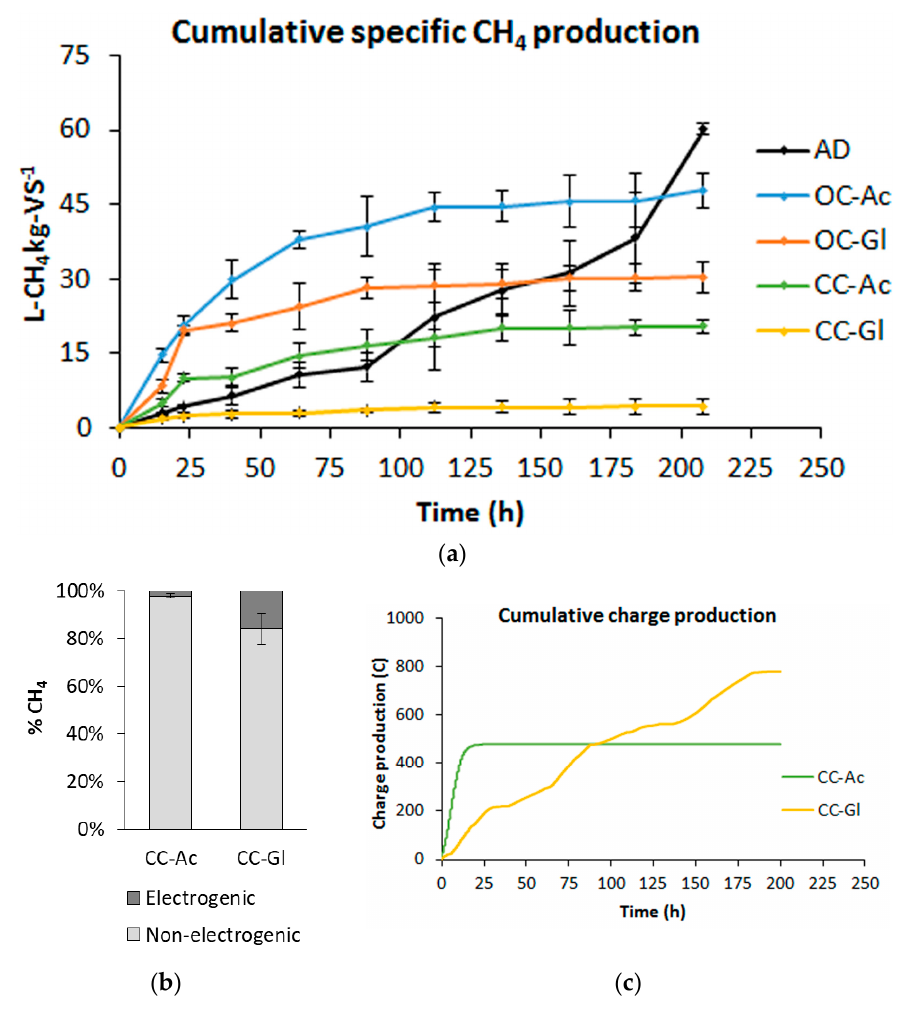
Figure 2. Results from combined AD-BES reactors working under acidogenic conditions: ( a ) specific CH 4 production for reactors; ( b ) theoretical CH 4 production by electromethanogenic processes; and ( c ) current consumption profiles of the closed-circuit (CC) reactors.